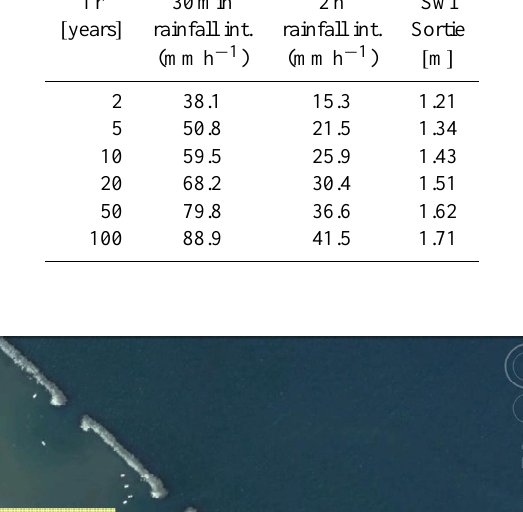
sea levels and the most intense are from the NE (Bora). The highest waves (greater than 3 m) come primarily from N-NE